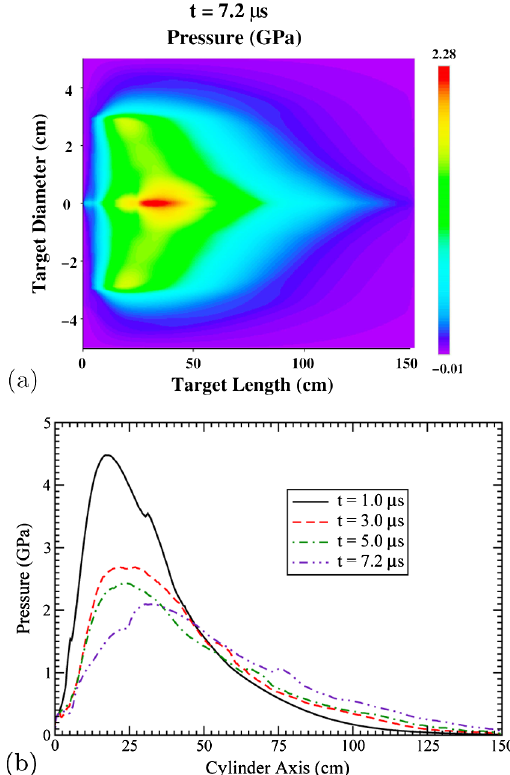
FIG. 13. (a) Pressure distribution in the cylindrical copper target, r ¼ 5 cm , L ¼ 1 : 5 m , irradiated by the 440 GeV SPS proton beam with (cid:1) ¼ 0 : 5 mm at t ¼ 7 : 2 (cid:2) s (end of the beam) and (b) pressure profiles along the axis at different times.